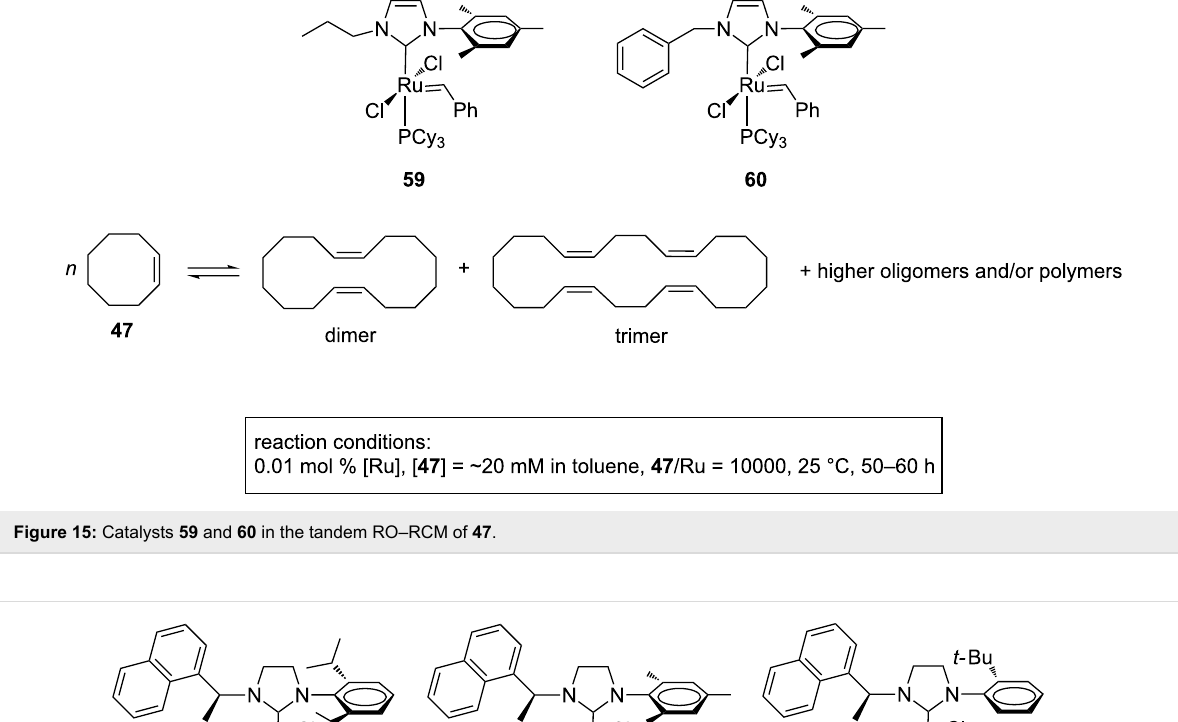
Figure 15: Catalysts 59 and 60 in the tandem RO–RCM of 47 .